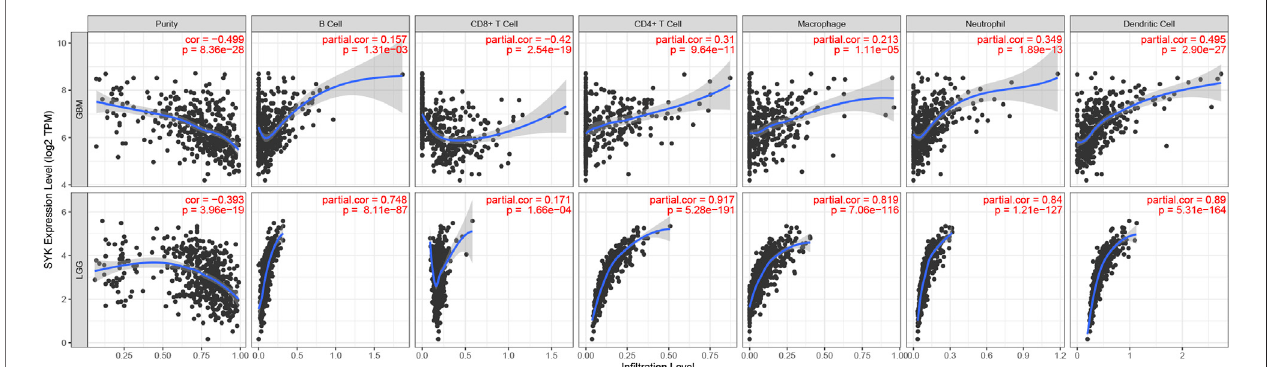
FIGURE 5 | Correlation between the expression levels of SYK and immune cells in diffuse glioma based on the TIMER algorithm.